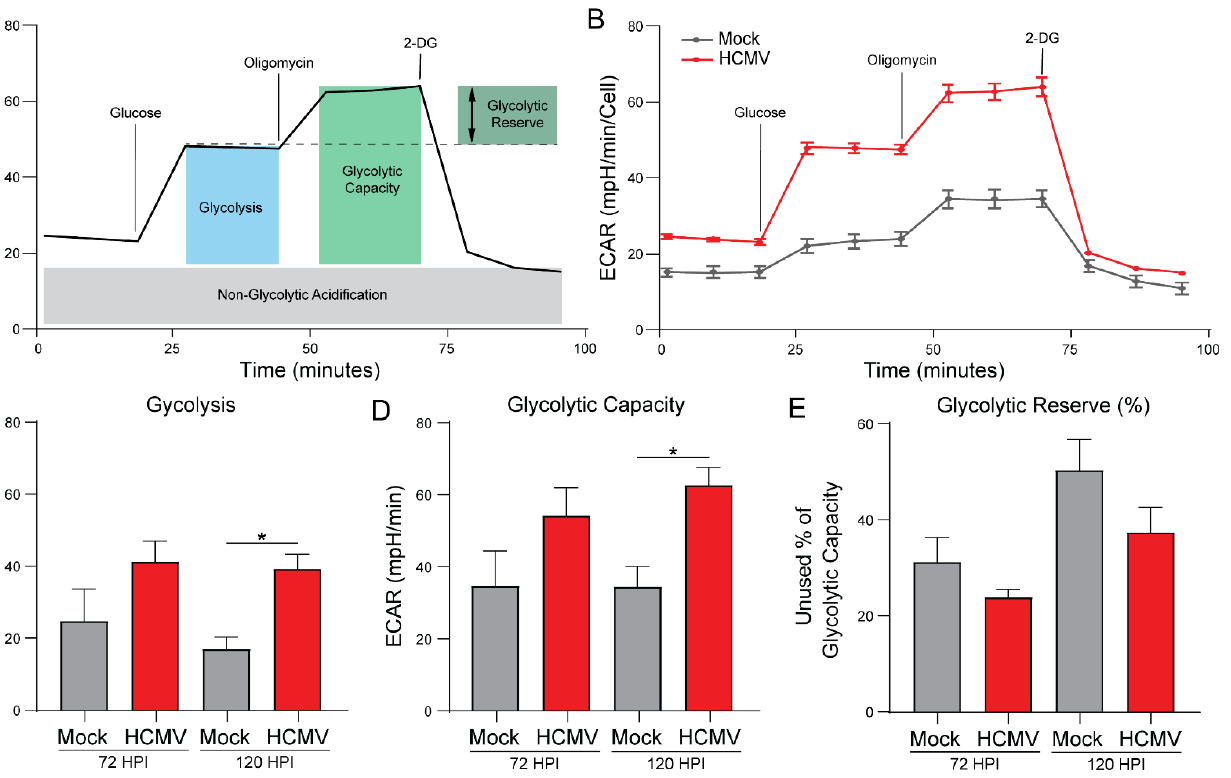
Figure 5. HCMV infection increases glycolysis and glycolytic capacity. ( A ) Measurements of the extracellular acidification rate (ECAR) determined using a Seahorse XFe24 Glycolysis Stress Kit are illustrated. ( B ) Representative data output of LN-18 cells mock- or HCMV-infected. ( C ) Glycolysis, ( D ) Glycolytic Capacity, and ( E ) Glycolytic Reserve were derived from these measurements. All samples were normalized to cell number. Graphs represent pooled data from three independent experiments. Mean ± the SEM of at least 3 triplicates. *, p < 0.05.